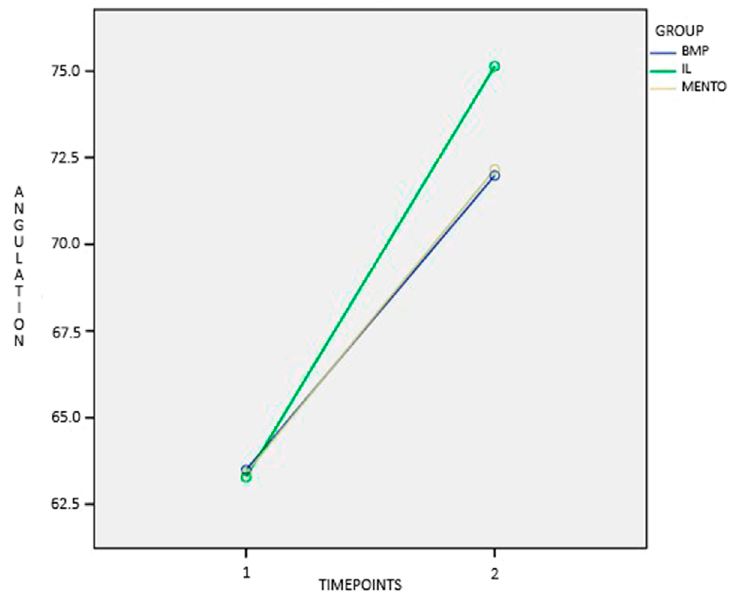
Figure 4- Interaction of time for PCCSs